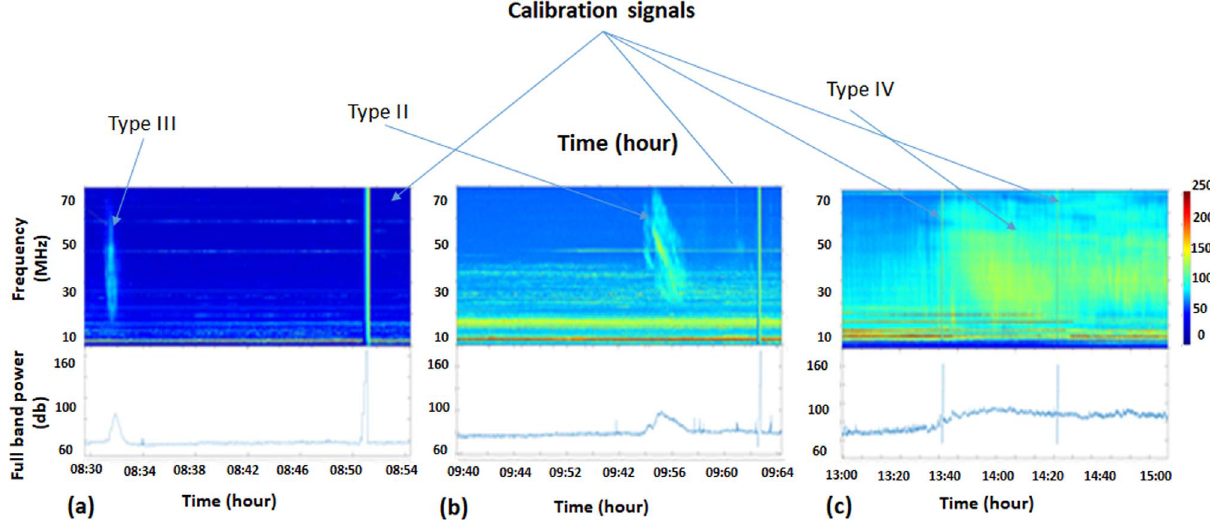
Fig. 1. Type II, III and IV bursts registered by the Nançay Decametre